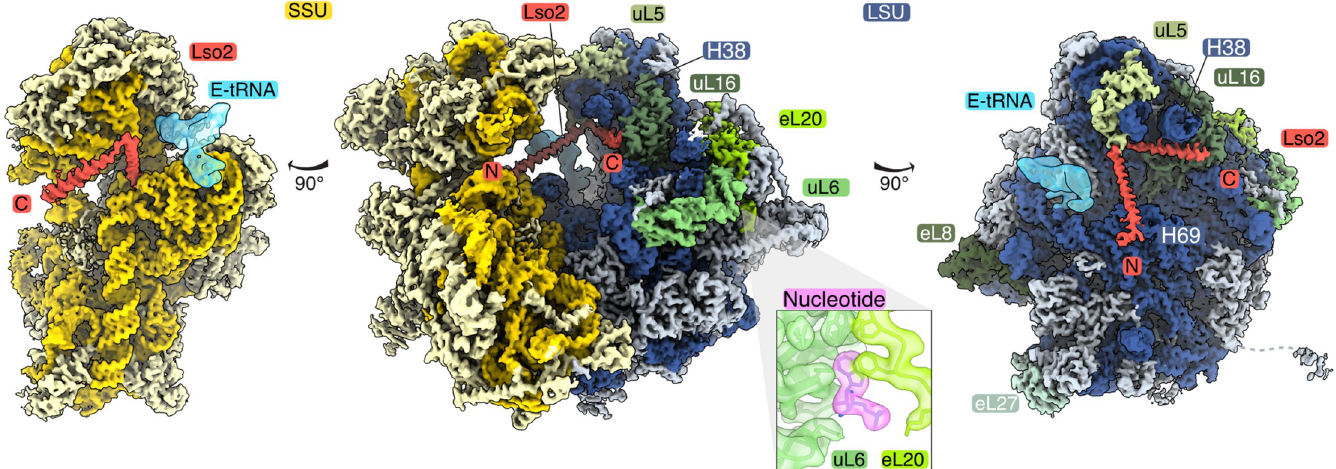
Fig 1. The cryo-EM structure of the P . locustae ribosome, bound to Lso2 and a structural nucleotide. Composite cryo-EM map consisting of maps focused on the LSU, SSU-body, and SSU-head is shown (EMD-11437). The complete ribosome is shown in the center, while the SSU (left) and LSU (right) are depicted in isolation on both sides. The SSU is colored in shades of yellow (RNA in gold, proteins in light yellow), while the LSU is colored in shades of blue (RNA in dark blue, proteins in light blue), with selected ribosomal proteins labeled and colored in shades of green. The hibernation and recovery factor Lso2 is highlighted in red. The inset showcases the nucleotide-binding site (purple) at the interface between the 2 LSU proteins uL6 and eL20 (shades of green), displayed by superimposing the cryo-EM map with the molecular model. C, C-terminus; cryo-EM, cryo–electron microscopy; E-tRNA, exit site tRNA; LSU, large subunit; N, N-terminus; SSU, small subunit.